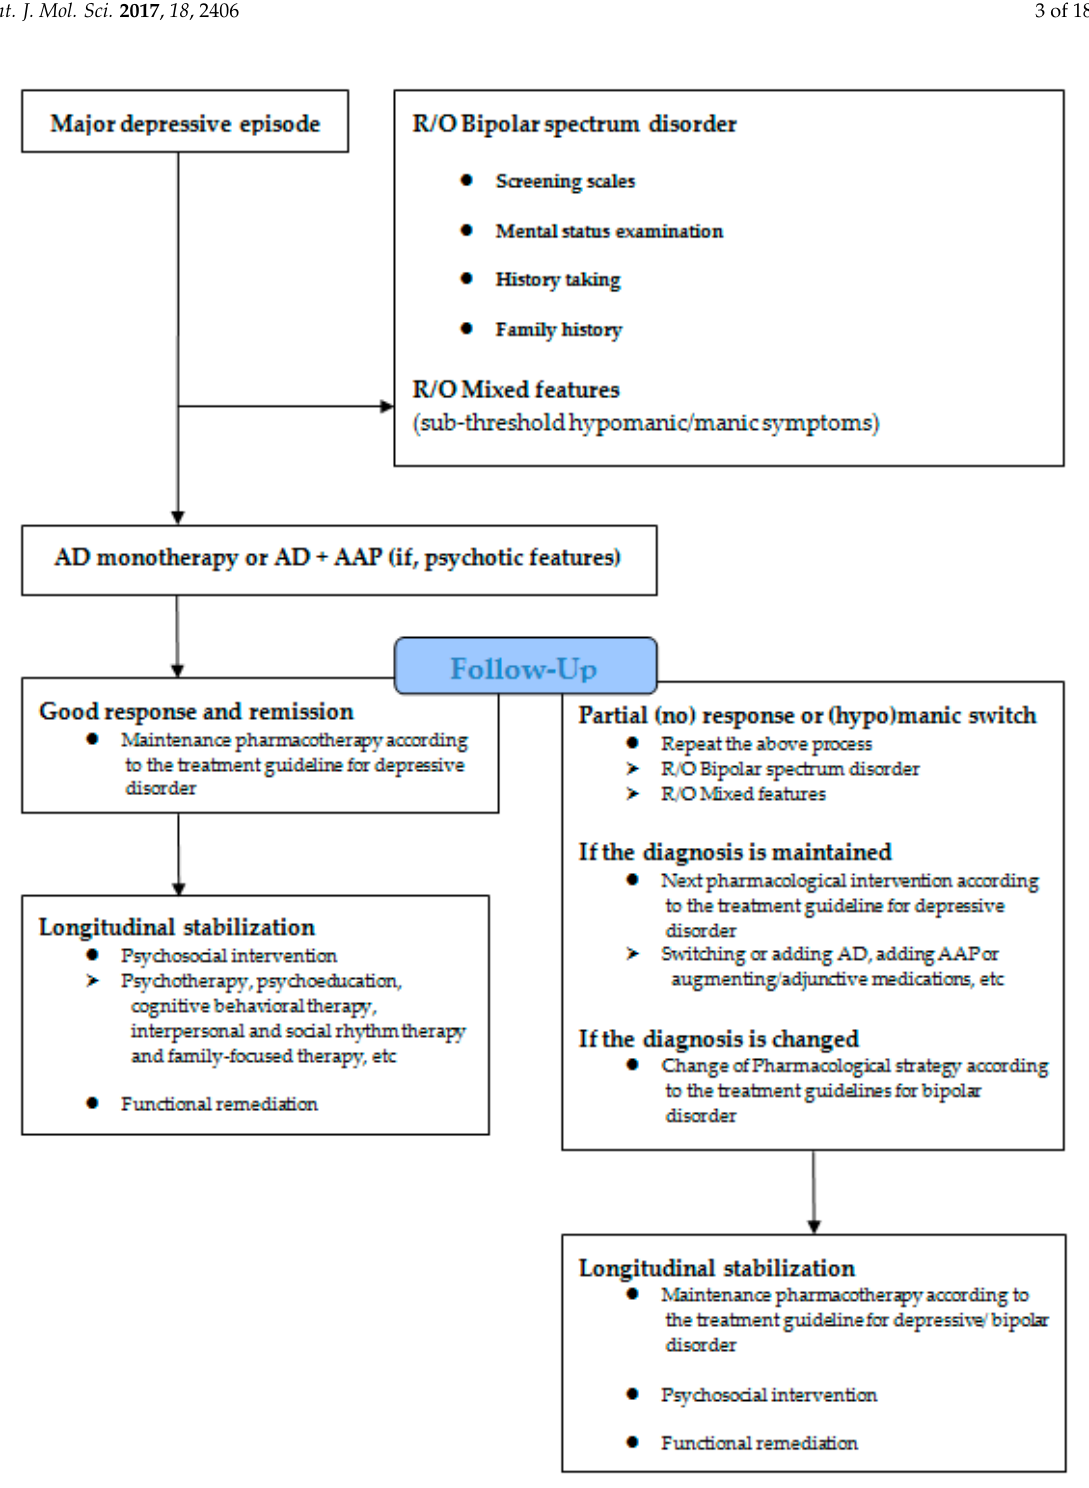
Figure 1. Treatment of major depressive episodes and the longitudinal stabilization of mood disorder. (Abbreviations: AD, antidepressant; AAP, atypical antipsychotics; MS, mood